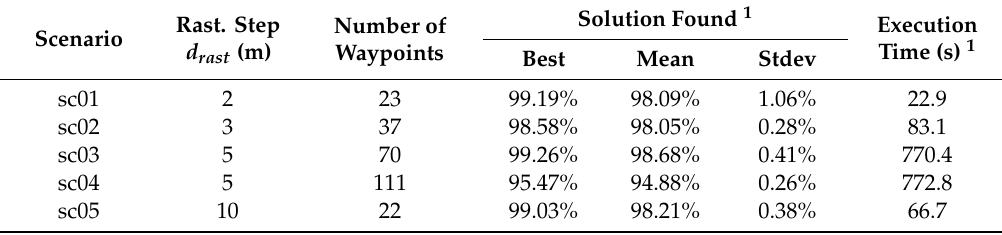
Table 9. Optimizations of the number and deployment of waypoints for the real scenarios.